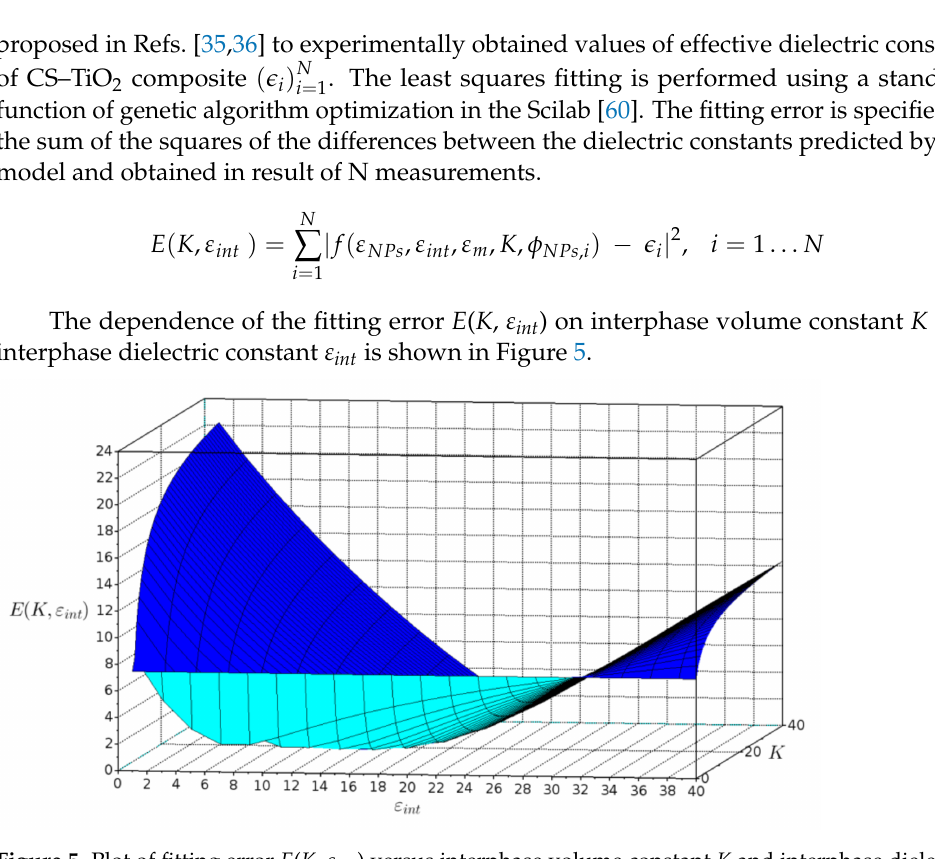
Figure 5. Plot of fitting error E ( K , ε int ) versus interphase volume constant K and interphase dielectric constant ε int